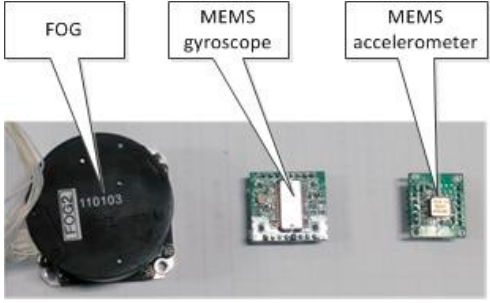
Figure 5. Picture of inertial sensors. Table 1. Comparison of the three types of sensors.